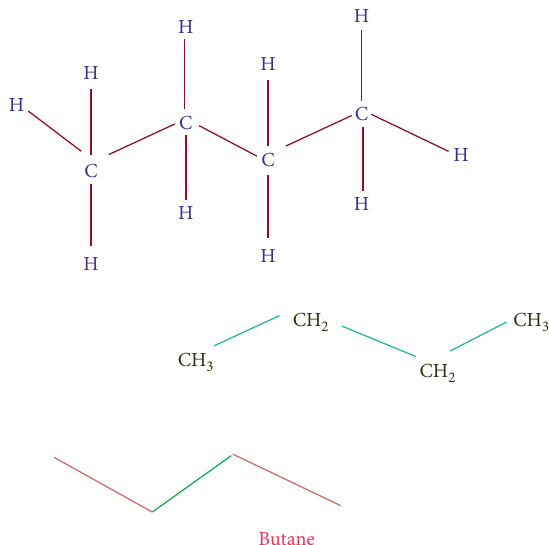
Figure 1: Clearly, structural formula of butane is isomorphic to P